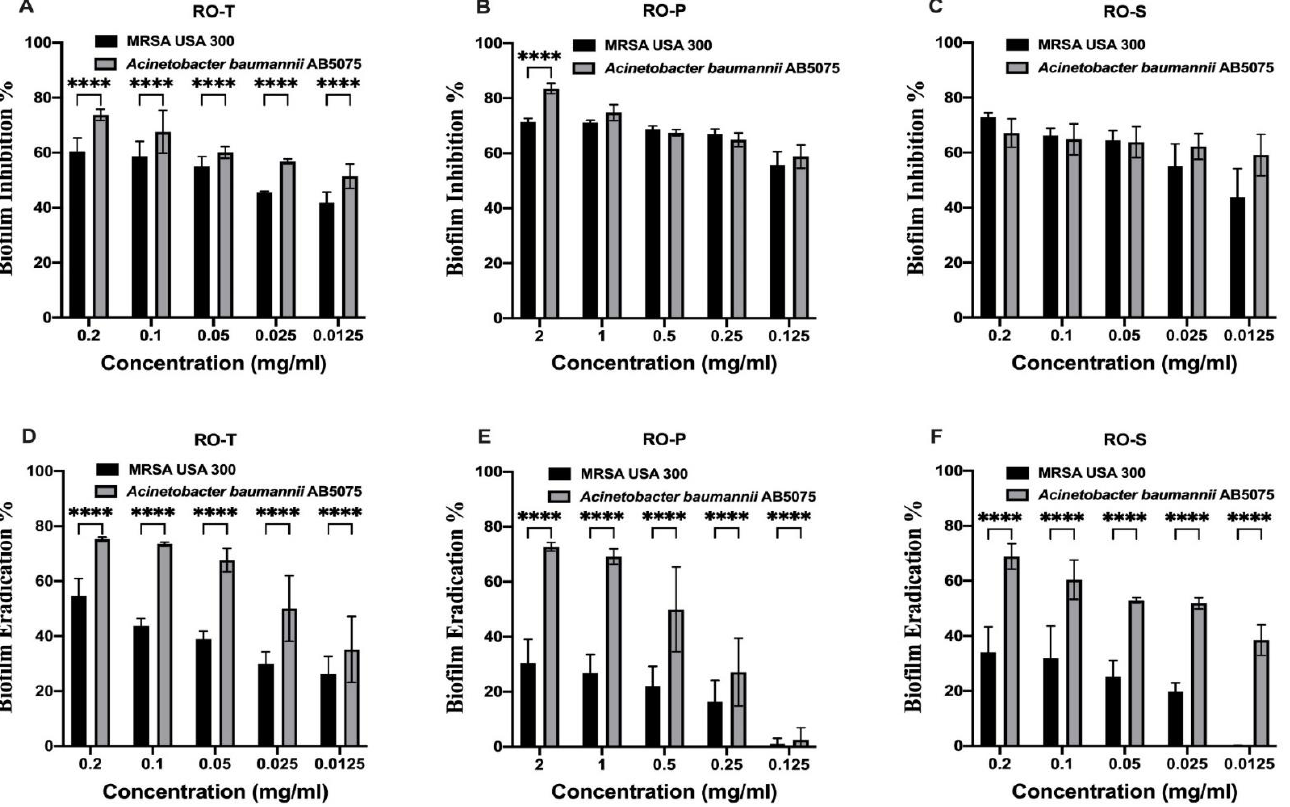
Figure 1. Antibiofilm activity. Effect of various concentrations of extracts RO-T, RO-P, and RO-S on